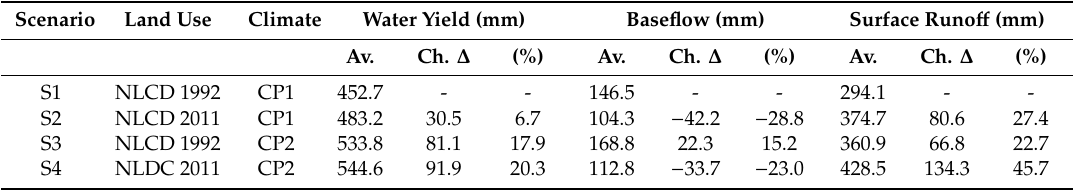
Table 9. Average annual change in water yield and baseflow in the LEC